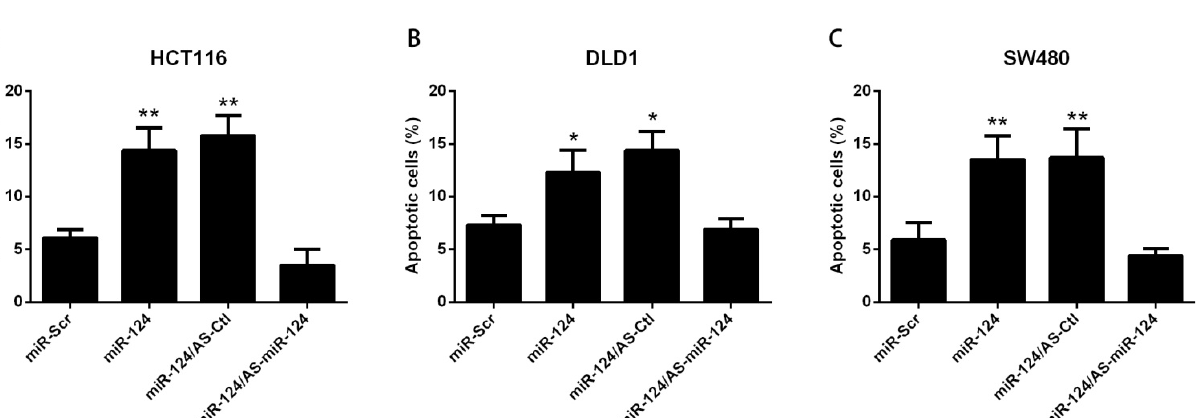
Figure 1. miR-124 regulates apoptosis in colorectal cancer cells. ( A – D ) DLD1, HCT116, SW480 or HT29 cells were transfected with miR-124 or antisense oligonucleotide (AS-miR-124), miR-Scr represented as the scrambled miRNA, and AS-Ctl represented the control of AS-miR-124 for 48 h. Apoptosis was assessed by Annexin V/PI assay; ( E ) miR-124 level was analyzed by real-time PCR, while HCT116 cells were transfected with miR-124 or AS-miR-124; ( F , G ) HCT116 cells were transfected with miR-124 or AS-miR-124, miR-Scr represented scrambled miR-124, AS-Ctl represented control of AS-miR-124 for 48 h; ( F ) Mitochondrial membrane potential was determined using JC-1. Loss of mitochondrial membrane potential was indicated by an increase in the green/red fluorescence intensity ratio. Fold-increase in green/red fluorescence was determined by comparing the results of treated samples with the level of the scrambled miRNA; ( G ) Caspase-9 activity or ( H ) Caspase-3 activity was analyzed by caspase-9 or caspase-3 Colorimetric Assay Kits respectively. Fold-increase in caspase-9 or caspase-3 activity was determined by comparing the results of treated samples with the level of the scrambled miRNA. The data are presented as mean ± SD of three independent experiments; ( I ) HCT-116 cells were seeded into six-well plates and treated with miR-124 or AS-miR-124. The fold-change of colony formation was determined by comparing the results of treated samples with the level of the scrambled miRNA. The data are presented as mean ± SD of three independent experiments. * p < 0.05 vs. control, ** p < 0.01 vs.